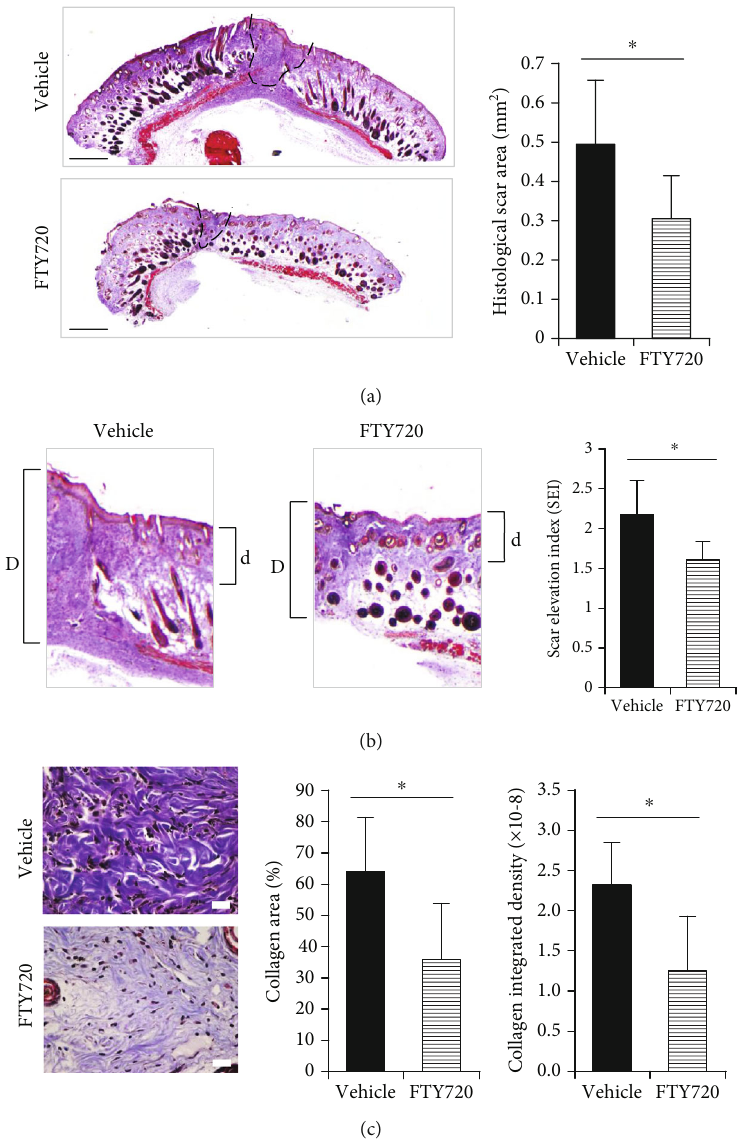
Figure 5: Histological analysis of the e ff ect of topical FTY720 injection on Day 14 cross-sectional scar formation. (a) Representative Masson ’ s trichrome stain images of the histological scar area (dotted line) are shown. The average cross-sectional scar areas were plotted (scale bars: 500 μ m, n = 7 ). (b) Quanti fi cation of scar elevation index (SEI). “ D ” indicates scar thickness, and “ d ” indicates adjacent normal skin thickness. SEI is de fi ned by the D / d ratio ( n = 7 ). (c) Representative images under high magni fi cation and quanti fi cation of the percentage of collagen area and collagen integrated density (scale bars: 20 μ m, n = 7 ). Two independent experiments were performed. Both showed similar results. The values shown represent means ± s : e : m : ∗ p < 0 : 05 , as determined by Student ’ s t -test or Welch ’ s t -test after F